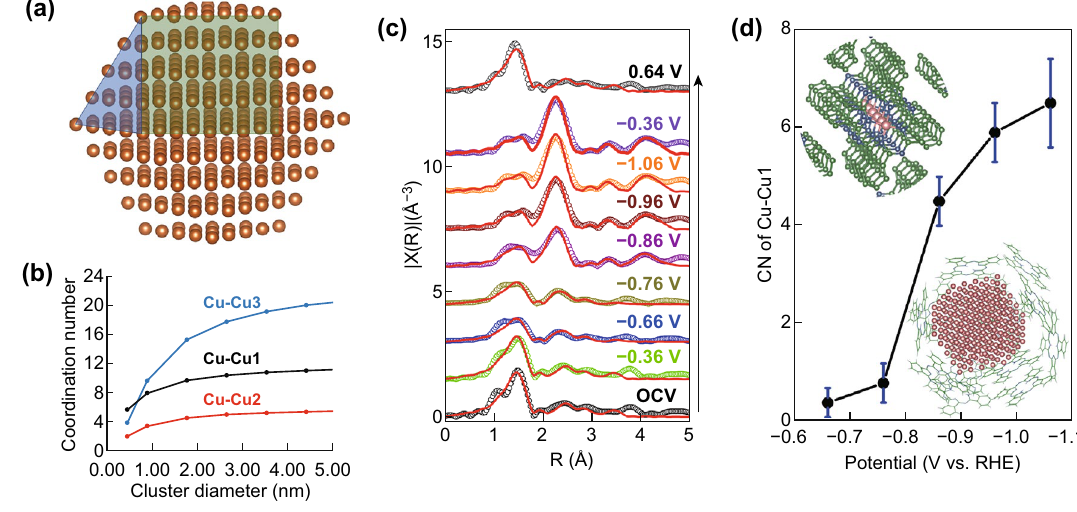
Fig. 6 Cu nanocrystal model and its size-dependent Cu–Cu CNs for the first three shells of nearest neighbors. a A five-shell cuboctahedral Cu nanocrystal model. b Size-dependent Cu–Cu CNs for the first three shells of nearest neighbors for a cuboctahedral Cu nanocrystal. c Fitting results of the EXAFS spectra of the CuPc catalyst at different potentials in CO 2 -saturated 0.5 M aqueous KHCO 3 . Fitted R-space. d First-shell Cu–Cu CNs of the CuPc catalyst at different potentials. The upper left inset shows the CuPc crystal structure, and the lower right inset